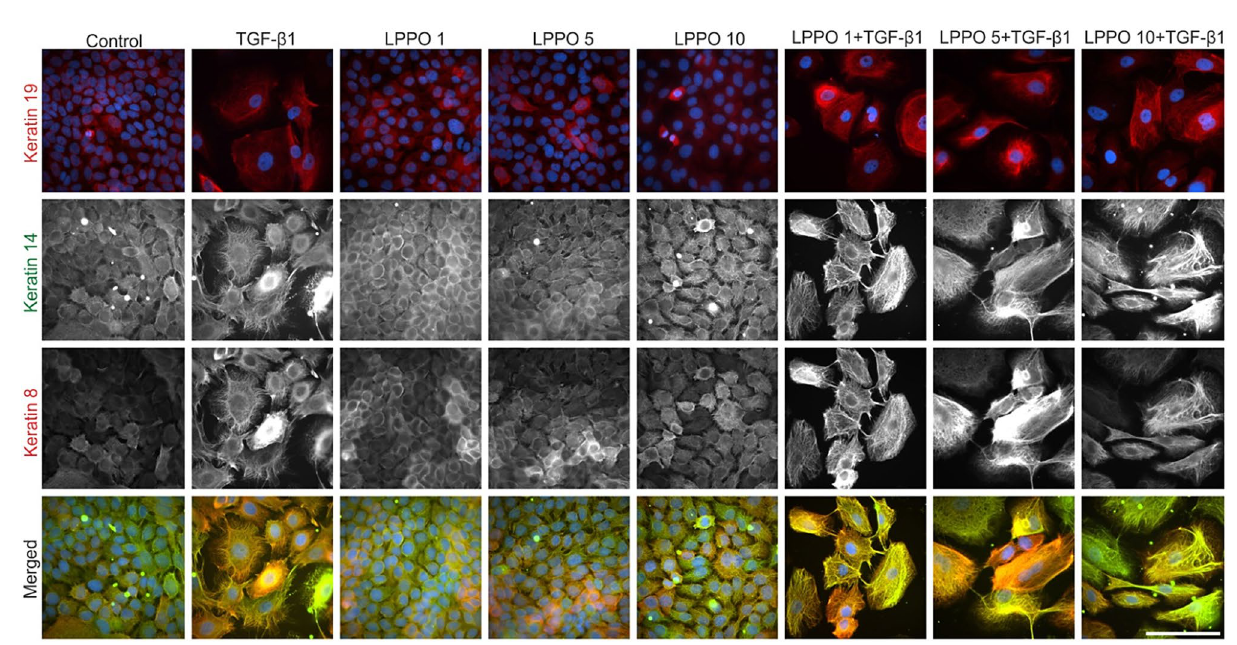
Figure 7. Immunofluorescent analysis of cytokeratins-8, 14 and 19 expression in HaCaT cells cultivated with LPPO (1, 5, and 10 mg/L) in presence or absence of TGF-β1 (30 ng/mL) (scale bar = 100